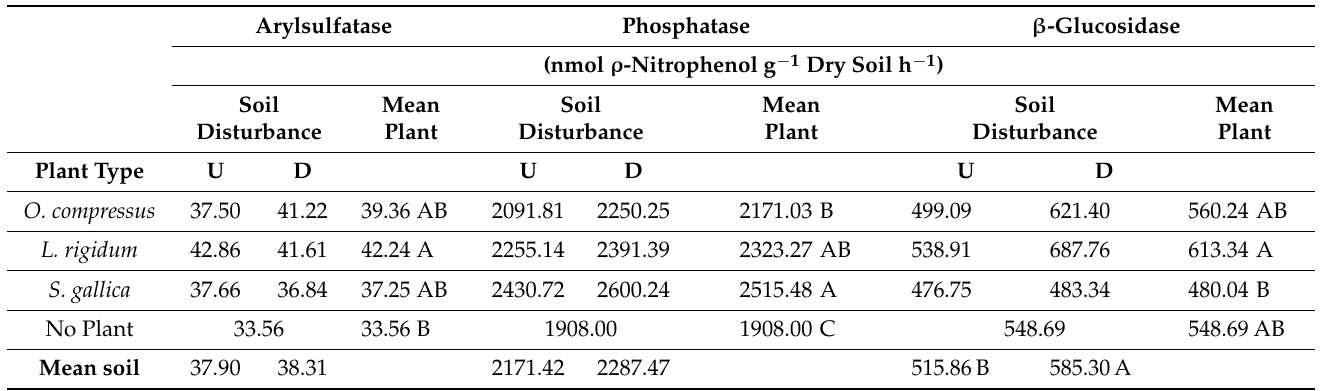
Table 4. Effect of previous type of plant and soil disturbance on soil enzymatic activities of arylsulfa- tase, phosphatase and β -glucosidase after wheat